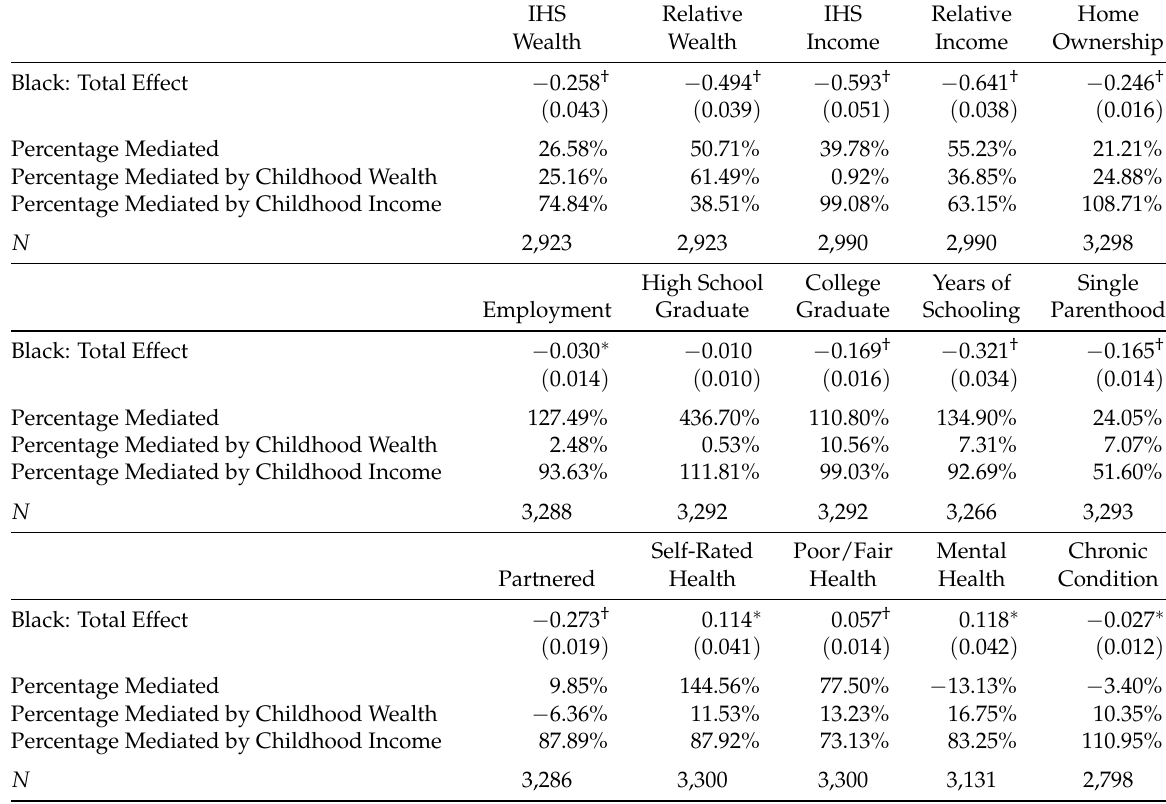
Table 4: Replication with NLSY97 for all outcomes: y -standardized coefficients or AMEs for being black and standardized coefficients or x -standardized AMEs for childhood wealth and